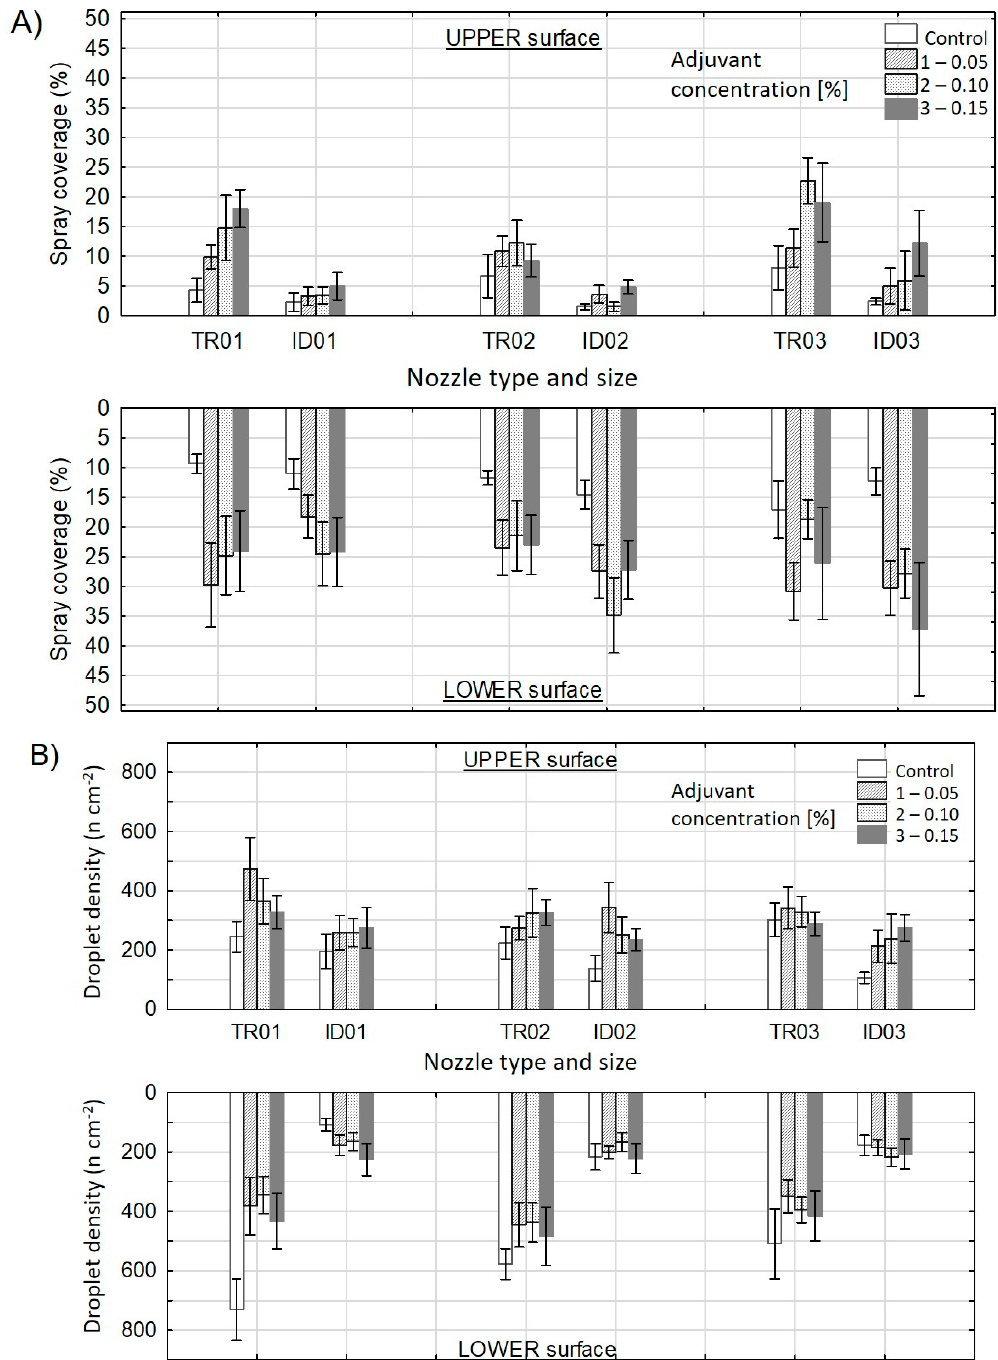
Figure 2. Effects of Agral 90 adjuvant concentration and nozzle type and size (TR—fine spray hollow cone nozzles; ID coarse spray flat fan air-inclusion nozzles); nozzle sizes 01, 02, 03 acc. to ISO 10625:2018 on: ( A ) spray coverage on the upper and lower leaf surface (%) (mean); ( B ) droplet density on the upper and lower leaf surface (n cm − 2 ) (mean). Table 4. The ANOVA summary table for data sets of spray coverage (A) and droplet density (B) on upper and lower surfaces of apple leaves obtained during the treatments with adjuvant Silwet L-77. The denotation NS marks not significant effects or interactions at p < 0.05.